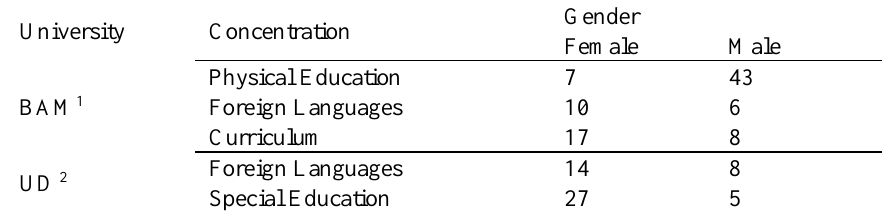
Sub-sample of first-year students, according to university, concentration and